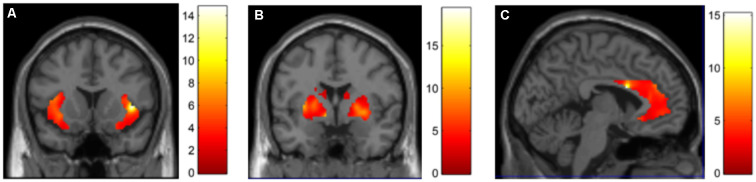
DBS-evoked changes in brain perfusion with 15O CO2 PET. Contrasting DBS on at contact 0 + 1 (bipolar) > contact 3 (unipolar), we identified increases in perfusion in the (A) insula, (B) basal ganglia and (C) anterior cingulate.